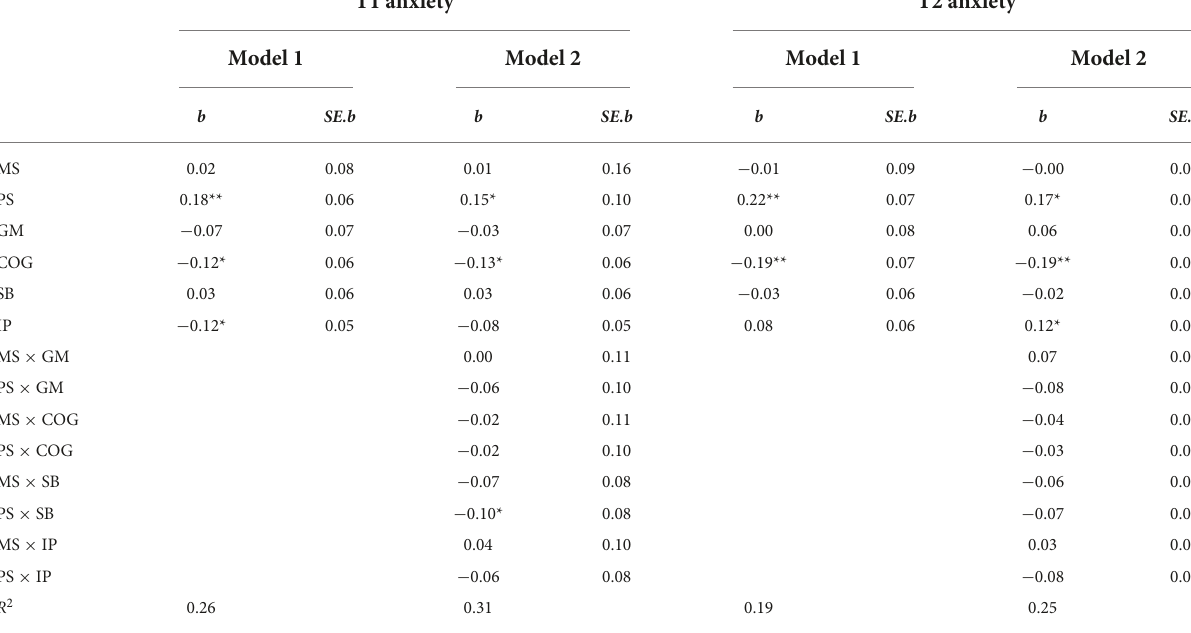
TABLE 5 The main and interaction effects of motivational-regulation strategies and self-regulated writing strategies on writing anxiety at two time